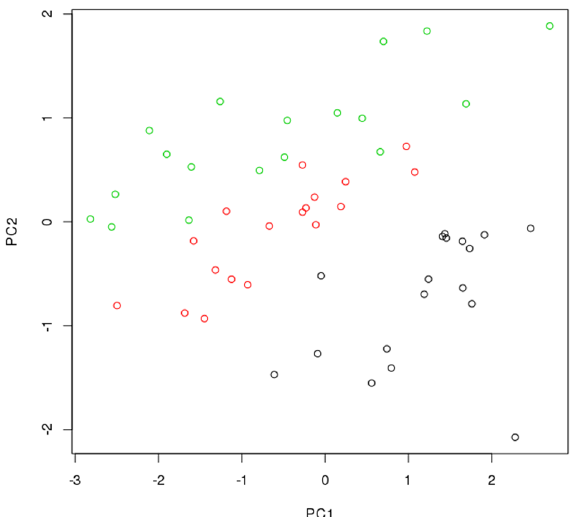
Figure 1. The results of PC analysis of microarray expression data in classical (black dots), non-classical (green dots) and intermediate (red dots) monocytes. Only probes in genes whose expression was initially measured (and expressed well on the array) were selected for this analysis. PC1 and PC2 are the first two principal components estimated based on the expression data with the aid of the prcomp function in R 49 .